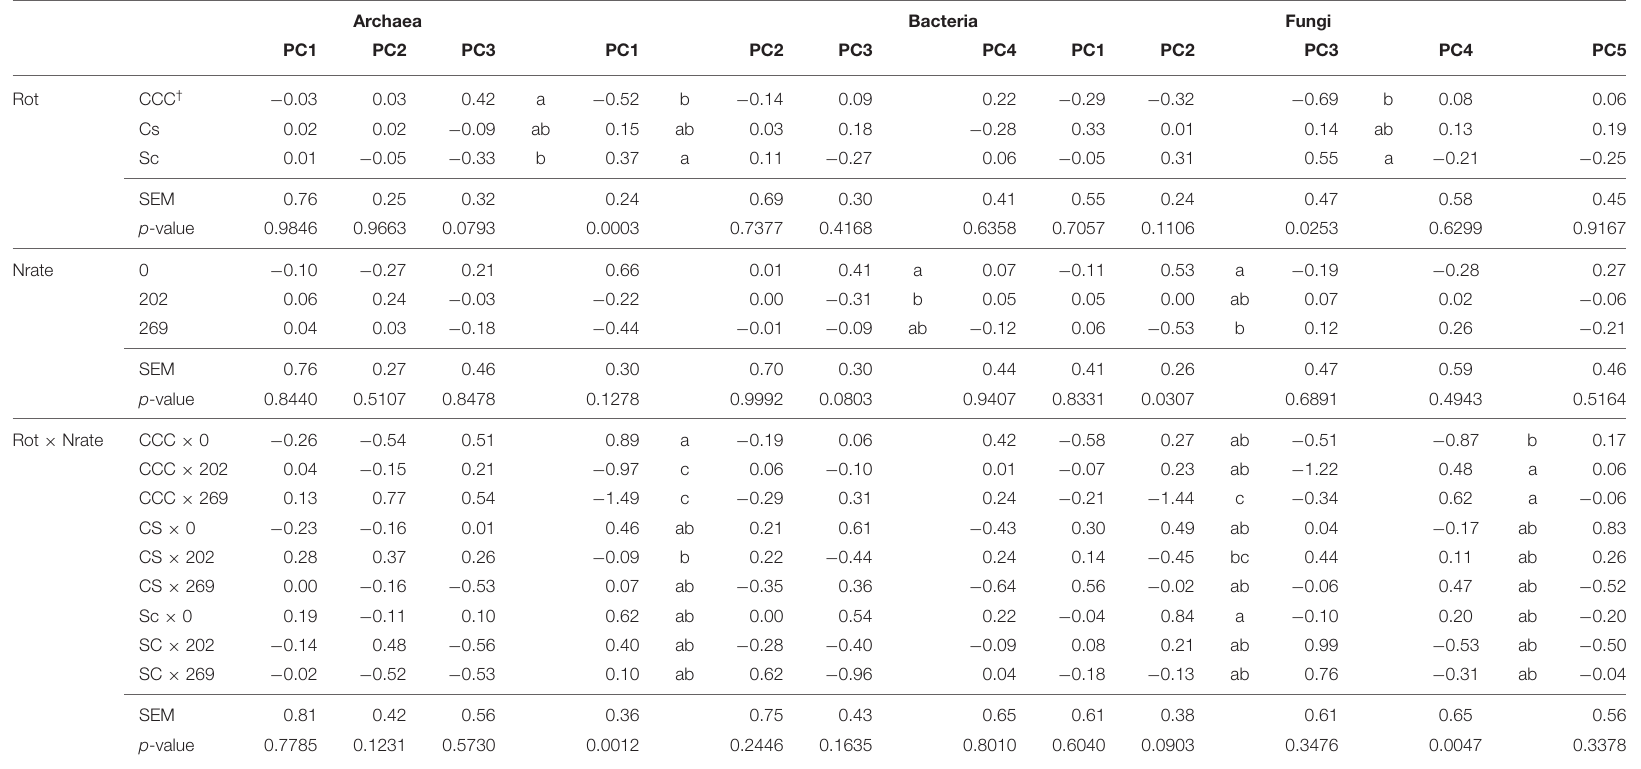
TABLE 5 | Mean values, standard error of the mean (SEM), and probability values ( p -values) associated with the analysis of variance (ANOVA) results for the effects of Rotation (Rot), N fertilization (Nrate), and their interaction on each group of principal components (PCs) calculated for archaea, bacteria, and fungi taxa datasets comprised of indicator ASVs. Archaea